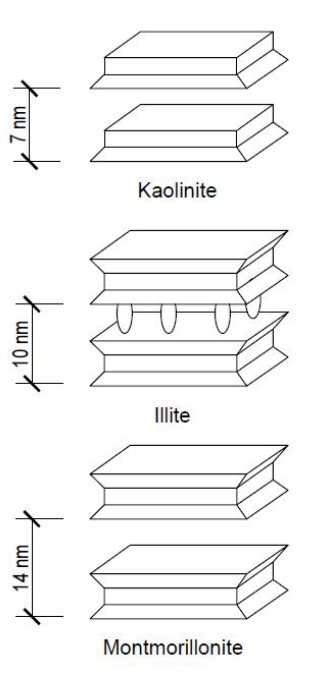
Figure 9. Type of clay – kaolinite, illite and mont-